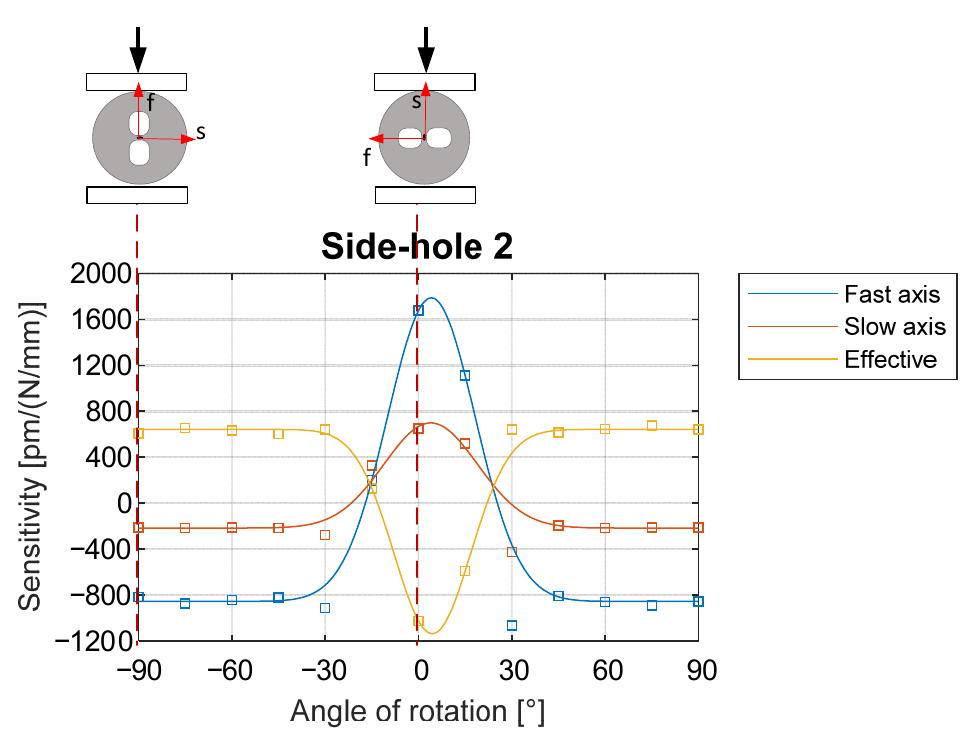
Figure 2. Sensitivity of peaks in the side-hole fiber under the force-loading conditions. Based on [29]. If force is applied along the slow axis of a fiber (angles − 30 ◦ –+30 ◦ ) the effective sensitivity to the load is negative, so the separation of peaks decreases; this results in the highest absolute value of 1150 pm/(N/mm). Meanwhile, when fiber is compressed along the fast axis or in the surrounding range (angles − 90 ◦ – − 30 ◦ and +30 ◦ –+90 ◦ ) compressive force increases the peak separation. In this case sensitivity is around 650 pm/(N/mm) [29]. In the work at hand, to have the highest sensitivity to the shrinkage in the out-of-plane direction, HB FBG was used in an orientation corresponding to the 0 ◦ angle loading case (slow axis is perpendicular to the plane of the composite). Location and orientation of FBG is shown in Figure 3